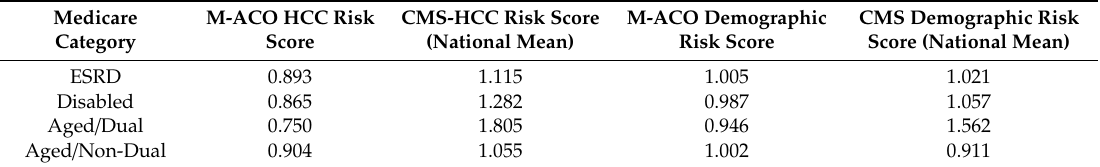
Table 6. HCC and Demographic Risk Scores by Medicare Category in M-ACO HCC compared with CMS (National